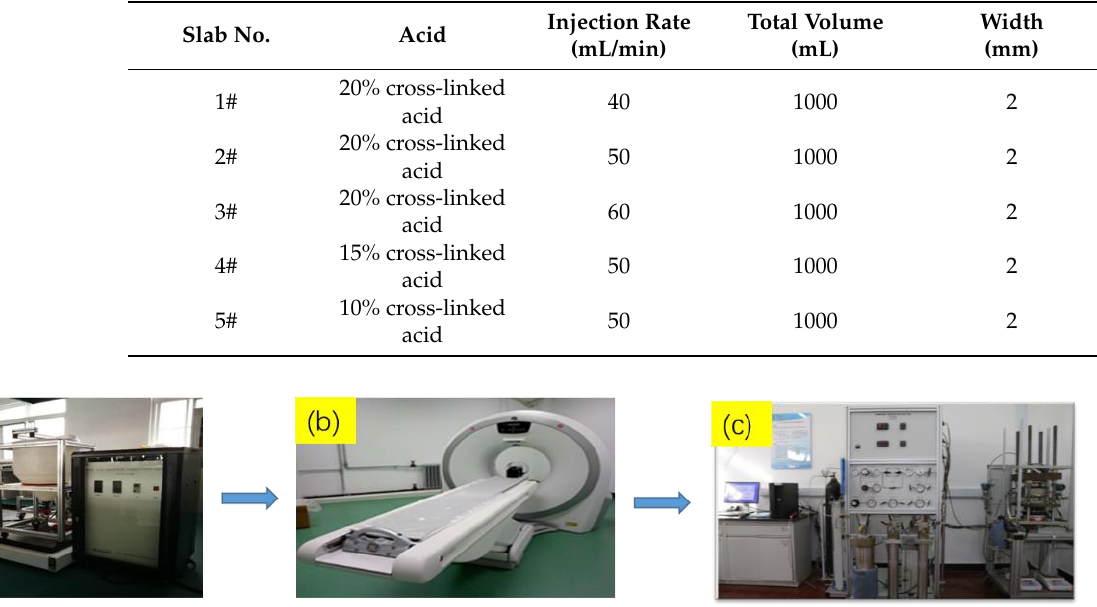
Table 3. Acid-etching experimental scheme.